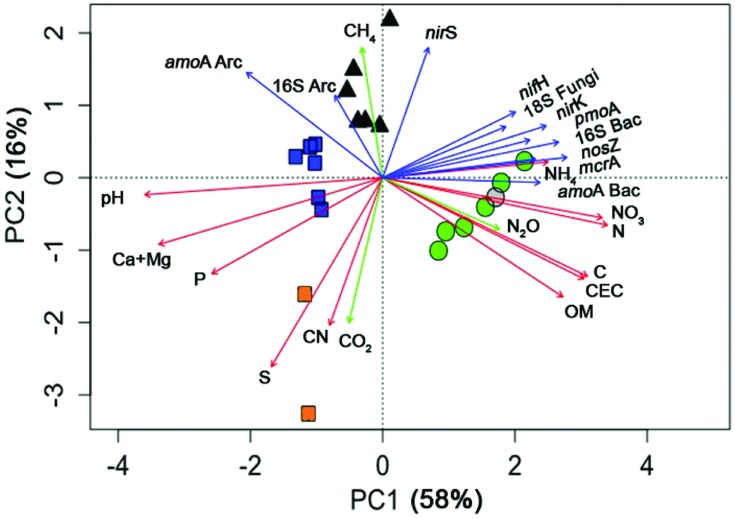
Principal Components Analysis of land uses (symbols) and soil parameters (vectors) in Southern Amazonia in the middle of the wet season. Data are shown for four different land use types, forest (), pasture (▲), soybean 25 years (), soybean 2 years (, and adjacent forest in a gray circle); and vectors for the soil chemical parameters, microbial genes, and GHG fluxes.